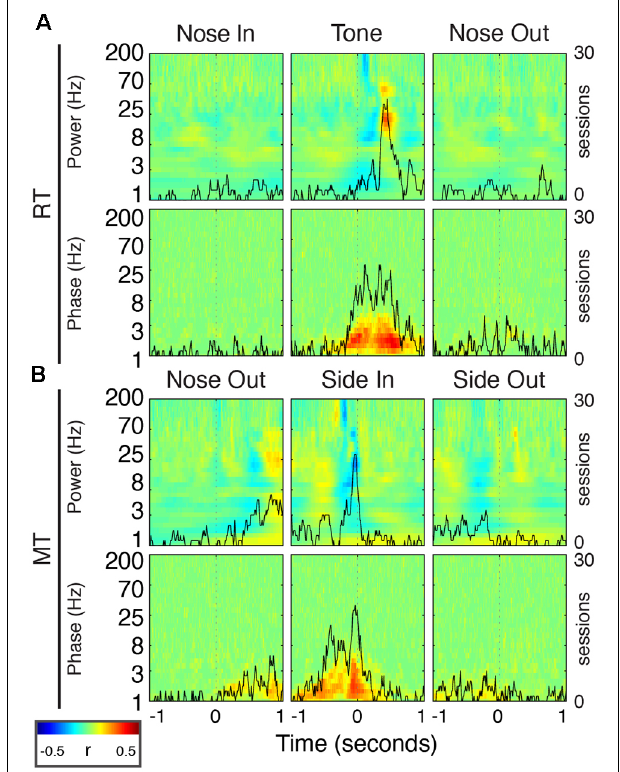
FIGURE 10 | FP oscillations predict task performance. (A) Peri-event correlations between RT and FP power (top) or phase (bottom) for the Nose In, Tone, and Nose Out events. Correlation values are session-averaged. Solid black lines indicate the number of sessions that reached significance ( p < 0.05) at each time point in the beta band (20 Hz) for power, and in the delta band (2.5 Hz) for phase. (B) Same as (A) for